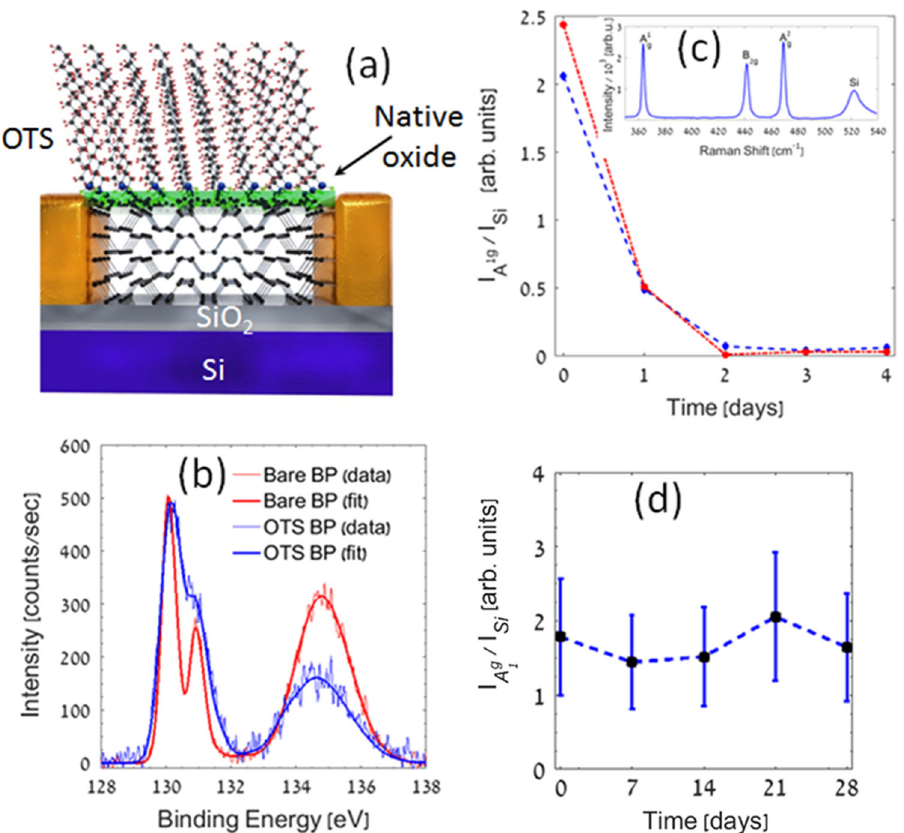
Fig. 1 a Structure of OTS-passivated BP in a FET device, showing a thin native oxide layer mediating the bonding of BP to OTS; b The P 2p XPS spectrum of bare ( red ) and OTS-coated ( blue ) BP together with their ( red / blue ) curve- fi tting. Normalized time-resolved Raman spectra showing peak and the Si substrate peak at 520 cm − 1 of uncoated ( c ) and OTS-coated BP ( d ) samples. A full scanned height ratios between the BP A 1 g spectrum is shown in the inset of c . Colors correspond to different samples in